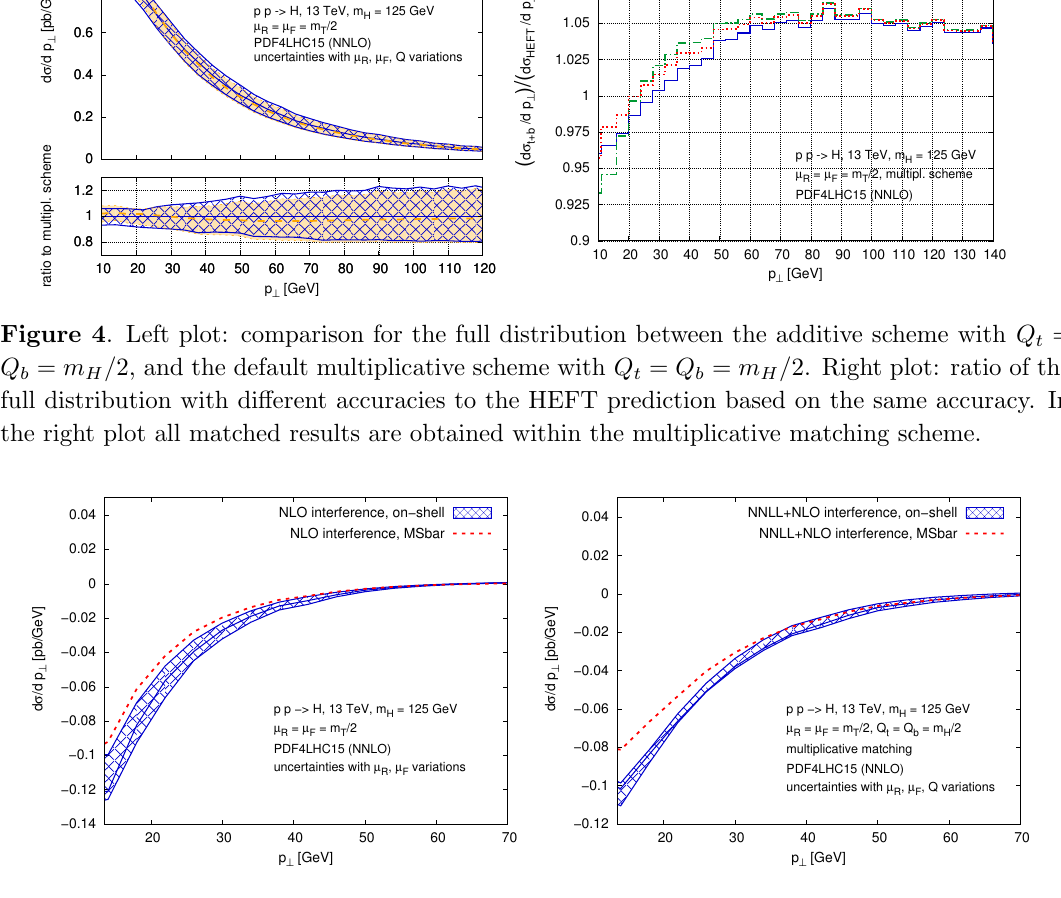
Figure 5 . The top-bottom interference contribution for the (cid:12)xed order (left) and the matched (right) distributions, for di(cid:11)erent choices of the mass-renormalization scheme. See text for